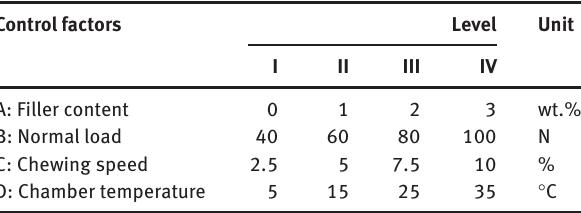
Table 2: Levels of variables used in wear